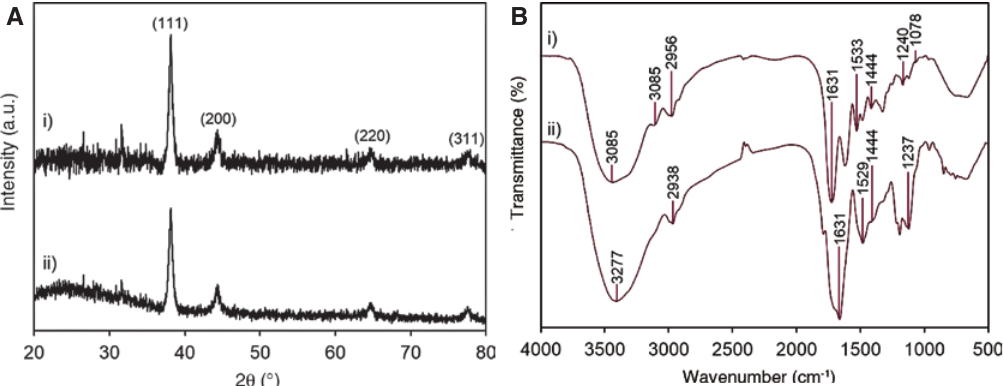
Figure 4: (A) XRD of bare Ag@Au (i) and Ag@Au@gelatin (ii) and (B) FTIR spectroscopy of gelatin (i) and Ag@Au@gelatin